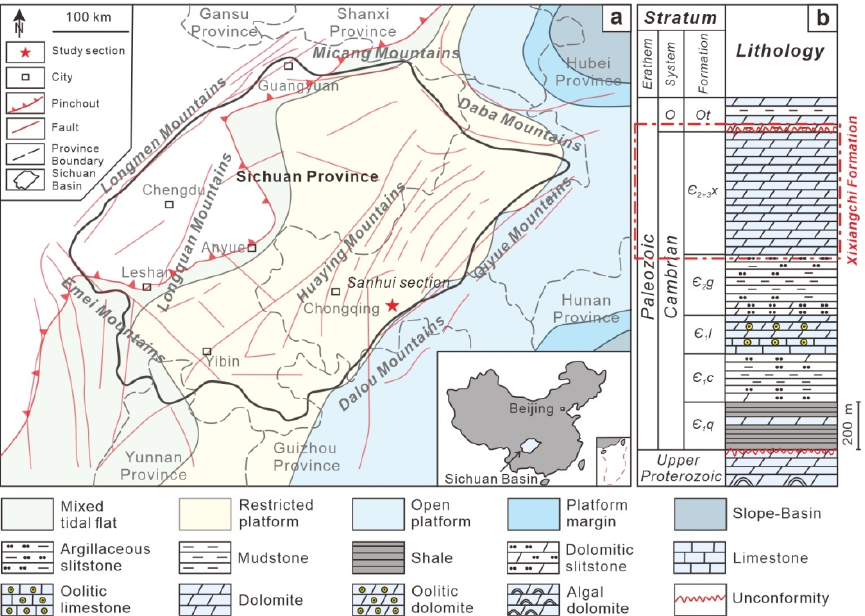
Figure 1. Location of the study section ( a ) and schematic diagram of the Cambrian stratigraphy ( b ) in the Eastern Sichuan Basin (modified from [40]).